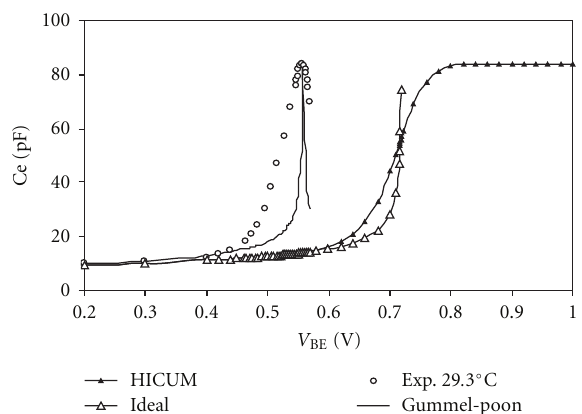
Figure 2: Experimental and simulated values of Ce at 29.3 ◦